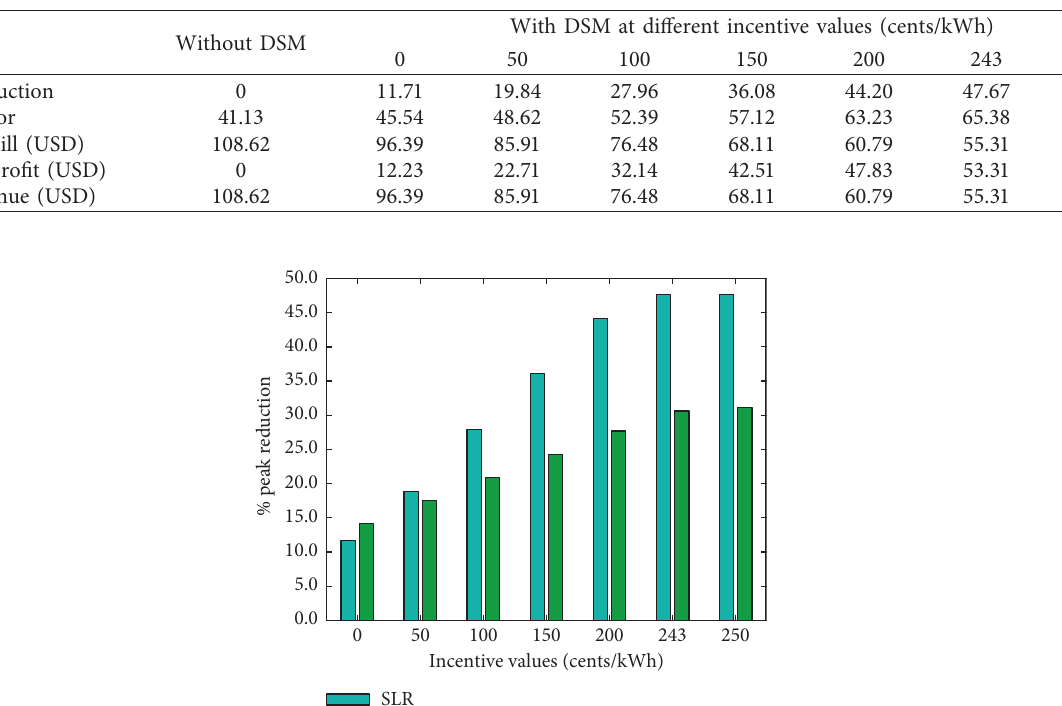
Table 6: Result summary of different indices before and after applying SLR DSM at different incentive values.